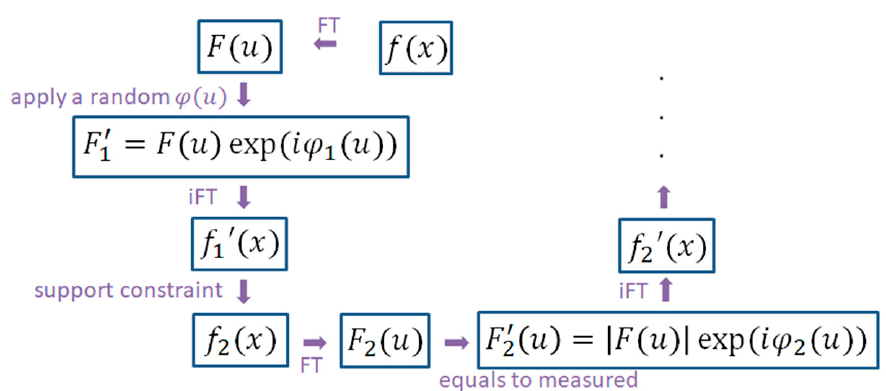
Figure 8. Flow of the iterative procedure of the CDI method.